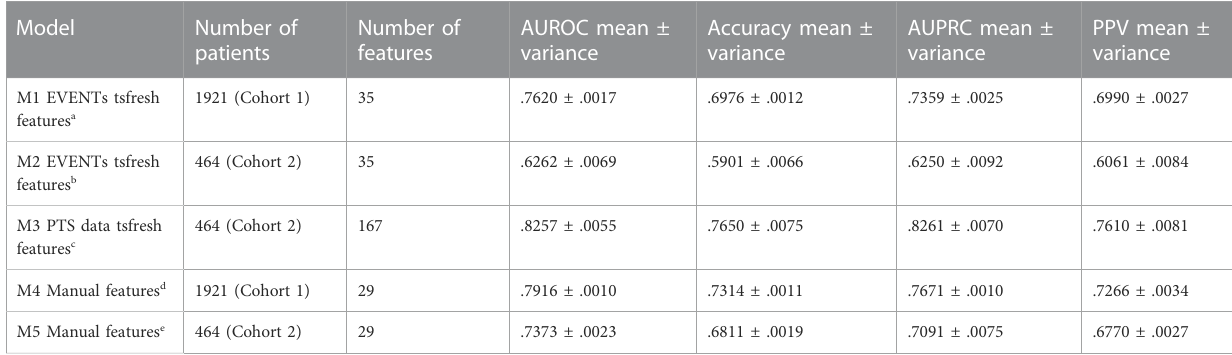
TABLE 2 Summary of model results.